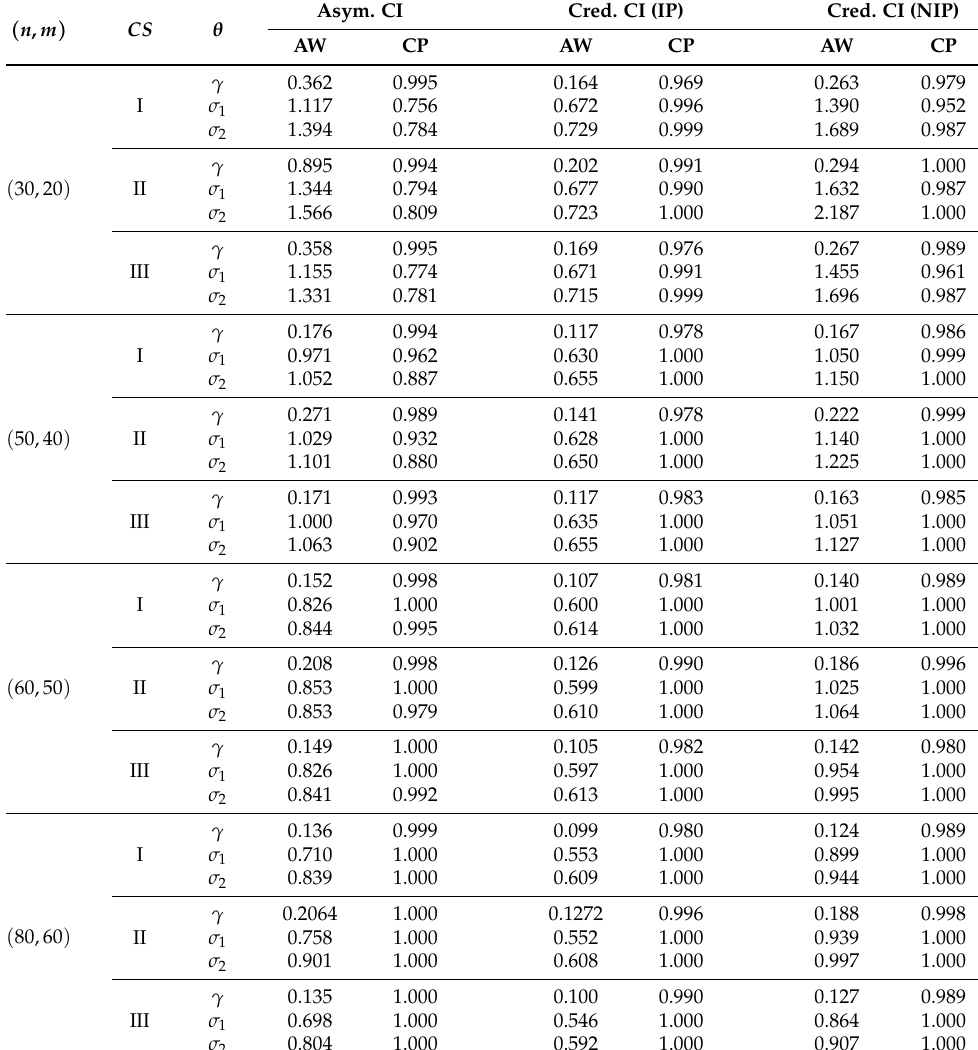
Table 9. Values of AWs and CPs for the asymptotic CI, Asym. CI, and credible CIs for informative prior, Cred. CI (IP), and non-informative prior, Cred. CI